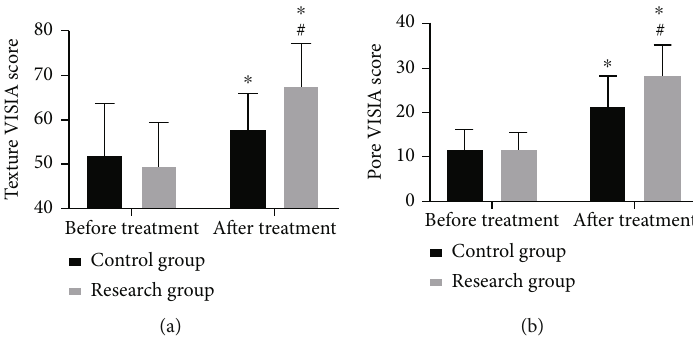
Figure 2: Comparison of skin improvement. (a) VISIA score of skin texture before and after treatment. (b) VISIA score of skin pores before and after treatment. ∗ Di ff erence vs. the situation before treatment. # Di ff erence vs. the control